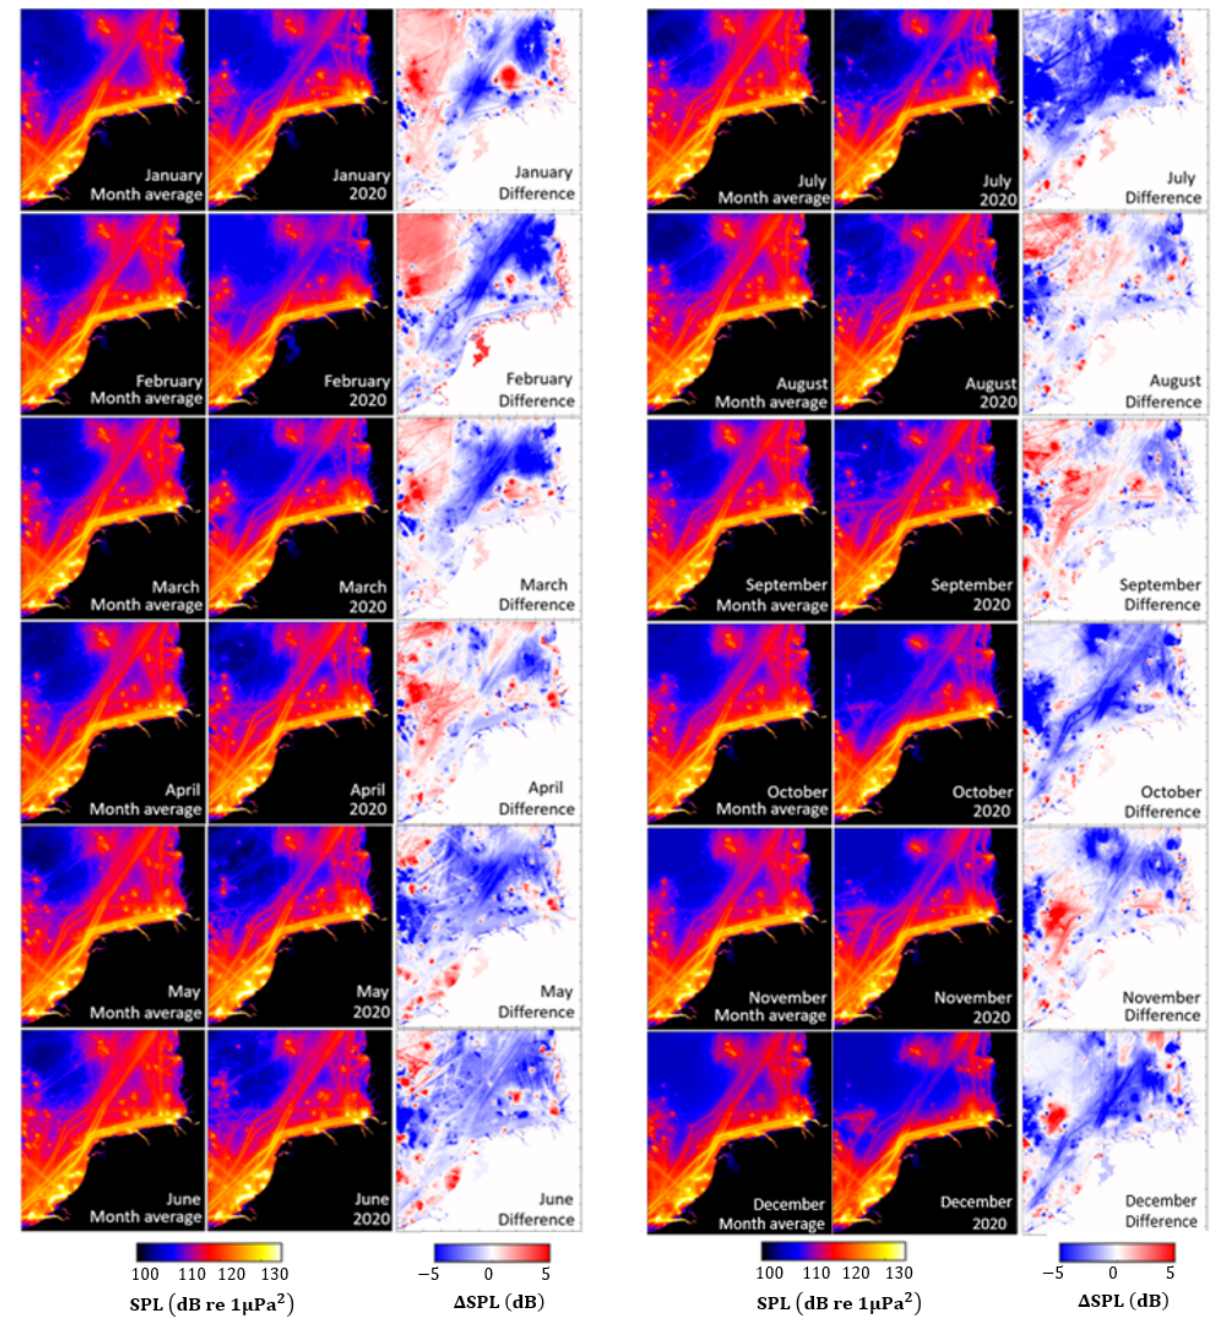
Figure 10. The monthly averaged sound maps before (as a month-average of 2017 to 2019 sound maps) and during the pandemic (2020) in test area 1. The frequency band is from 100 Hz to 10